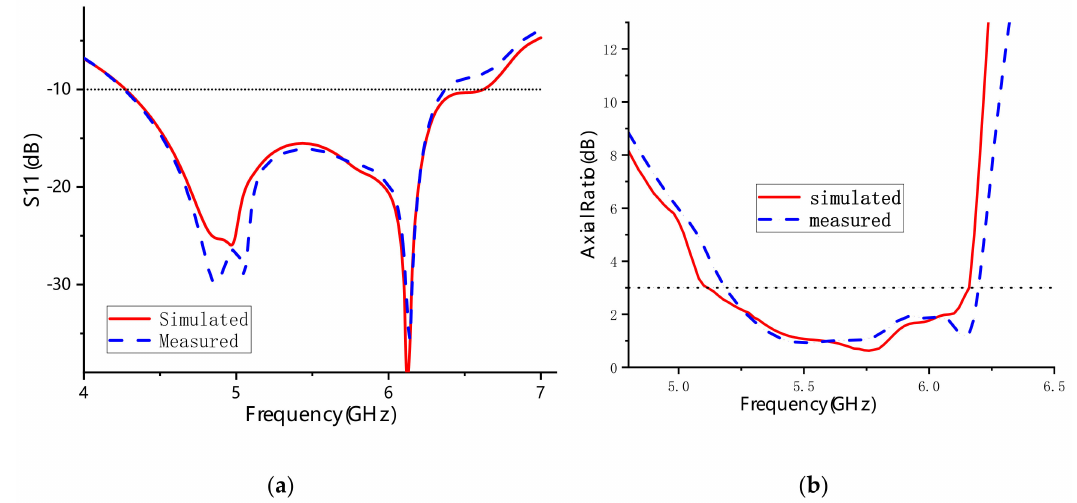
Figure 8. Simulated and measured characteristics of the proposed antenna: ( a ) S 11 ; ( b ) AR.